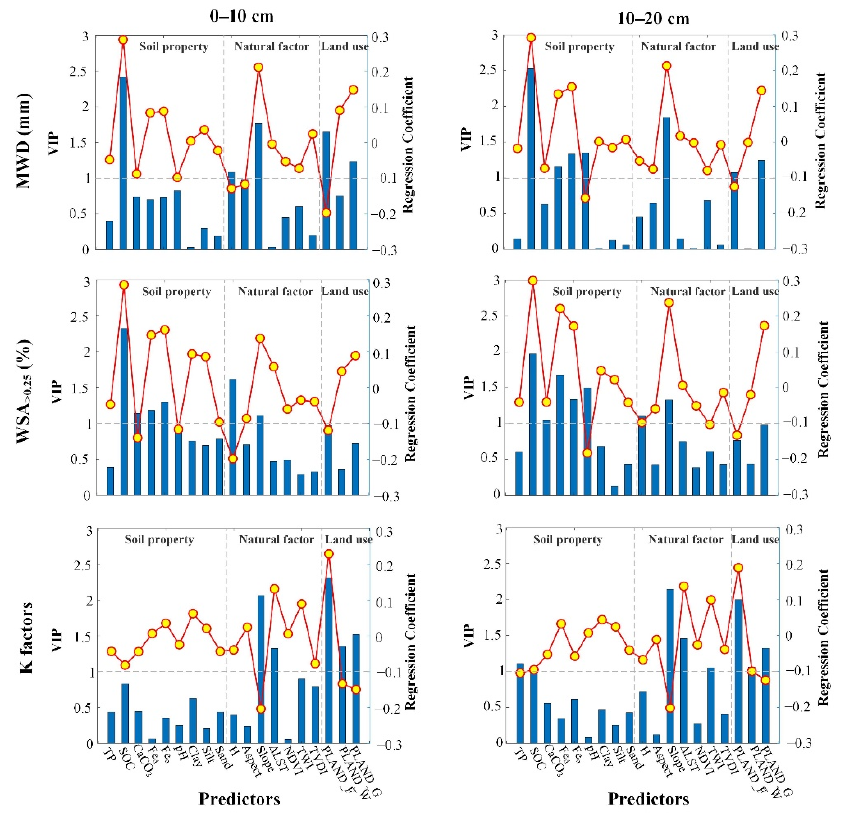
Figure 3. Variable importance values for the projection (bar) and regression coefficients (dotted line) in the Zhifanggou watershed. The predictors were classified as soil property, nature factors, and land use. The predictors with VIP > 1 are considered as important predictors. MWD: mean weight diameter; WSA >0.25 : percentage of water-stable aggregates greater than 0.25 mm; K factors: soil erodibility factor. TP, total porosity; SOC, soil organic carbon; CaCO 3 , calcium carbonate; Fe d , free iron; Fe o , amorphous iron; Clay, clay content; Silt, silt content; Sand, sand content; H, elevation; ∆ LST, the land surface temperature difference between seasons; NDVI, normalized difference vegetation index; TWI, topographic wetness index; TVDI, temperature vegetation dryness index; PLAND_F, PLAND_W, and PLAND_G, the proportion of the landscape occupied by farmland, woodland, and grassland,